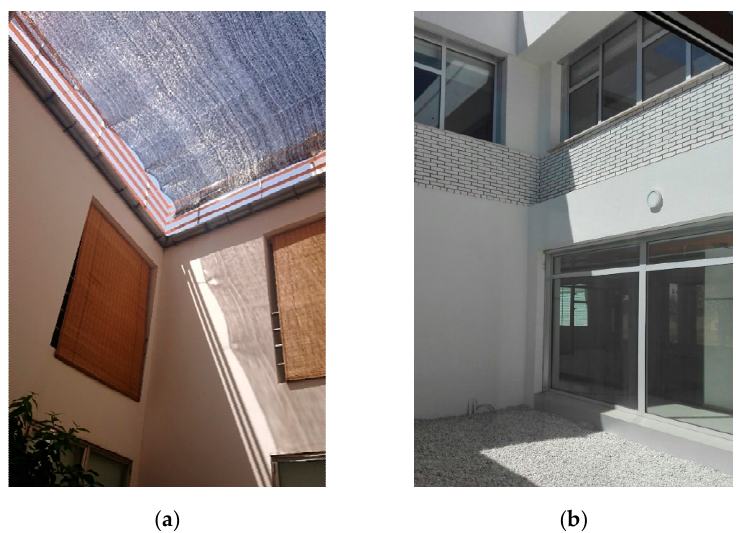
Figure 1. Images of the courtyards: ( a ) Courtyard A in Córdoba; ( b ) Courtyard B in